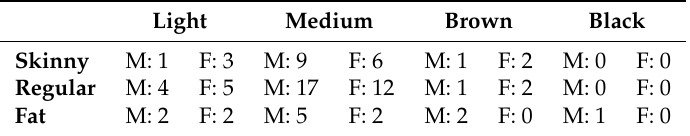
Table 1. The choice of participants regarding skin color and weight of the self-avatar for both male (M) and female